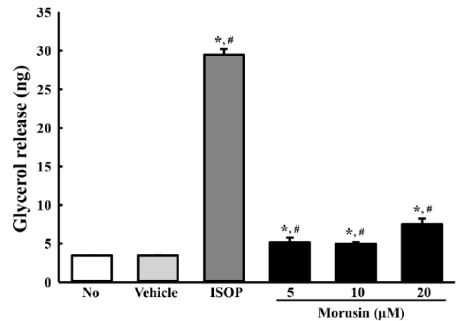
Figure 5. Free glycerol release of morusin-treated primary adipocytes. Released glycerol was measured in the supernatant of primary adipocytes treated with three different concentrations of morusin. The data represents the means ± SD of three replicates. * indicates p < 0.05 compared to the untreated group. # indicates p < 0.05 compared to the vehicle-treated group. ISOP; Isoproterenol.